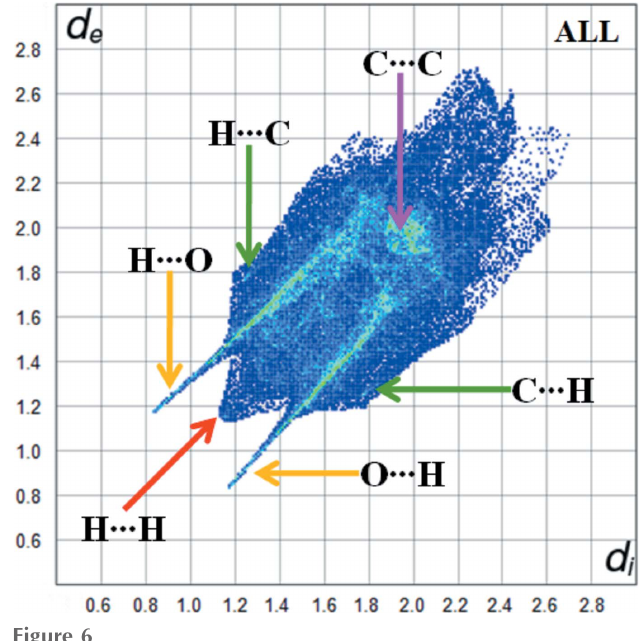
Figure 6 The overall fingerprint plot for the title compound.